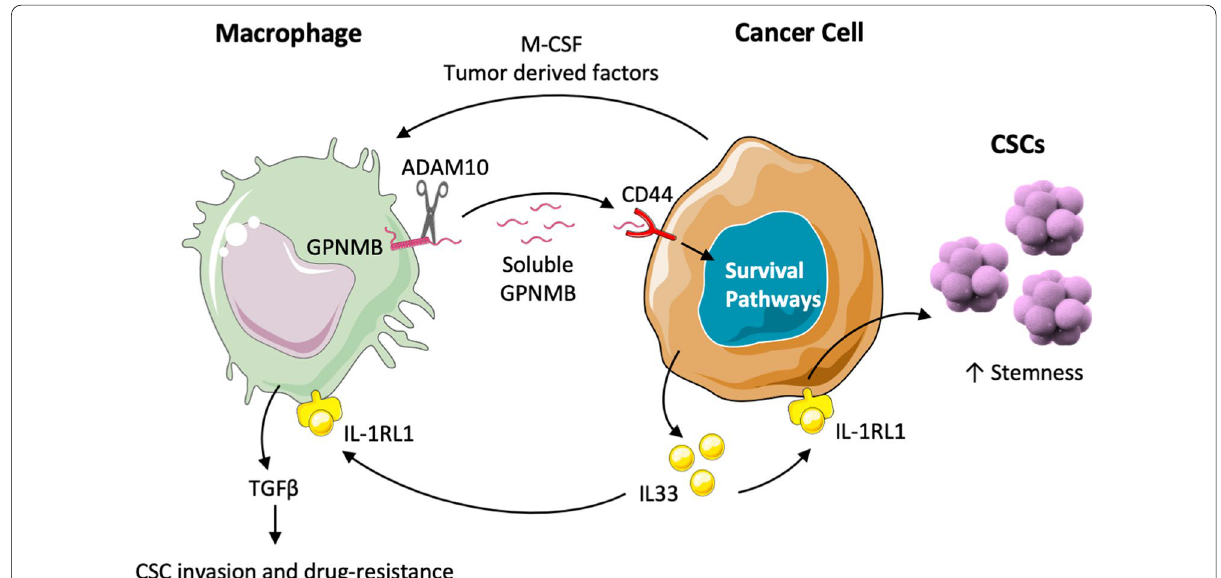
Fig. 3 The soluble protein GPNMB produced by macrophages induces cancer stemness via CD44 and IL-33. Cancer cells stimulate in macrophages the production of GPNMB by M-CSF and tumor derived factors. GPNMB can be cleaved from the membrane by metalloproteinases, such as ADAM10. Soluble GPNMB binds to the CD44 receptor and triggers the release of IL-33. This cytokine, through the binding to its receptor IL-1RL1, is able to expand the population of CSCs, and to stimulate macrophages to produce TGFβ, promoting CSC invasion and resistance to drugs. This figure was made with Servier Medical Art templates, which are licensed under a Creative Commons Attribution 3.0. Unported License (https:// smart. servi er.